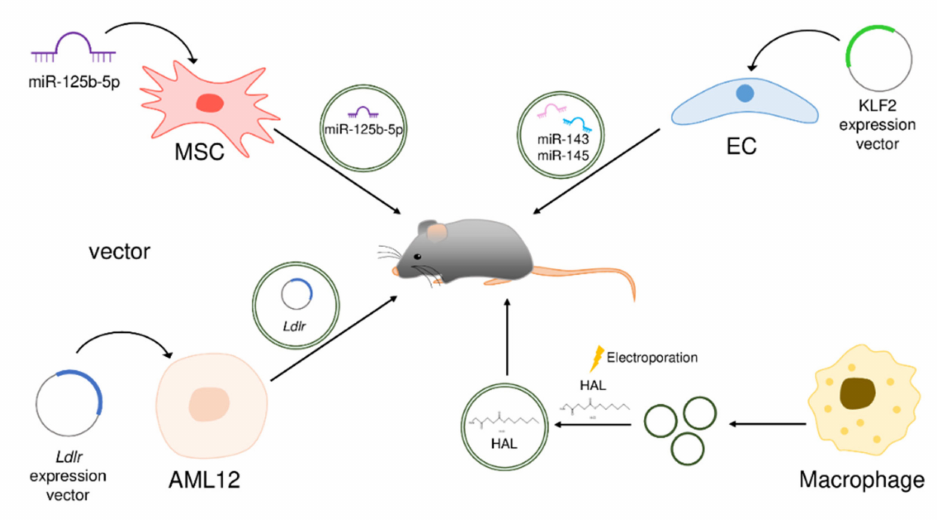
Figure 3. Studies on atherosclerosis therapy using exosomes.Modified exosomes carrying high levels of specific cargo were injected into atherosclerosis mouse models such as ApoE ( − / − ) or Ldlr ( − / − ) mice fed a high-fat diet by tail vein injection, and their therapeutic efficacy against atherosclerosis was investigated. Curved arrows represent transfection of cells with the indicated